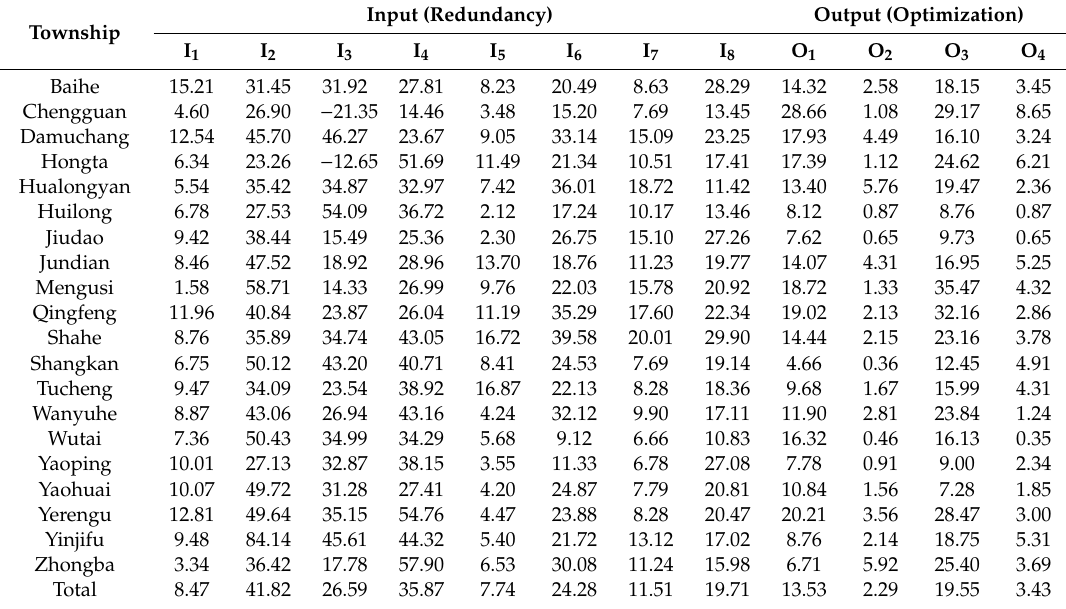
Table 3. Input and output optimization of rural land resources allocation in Fang County. Unit :